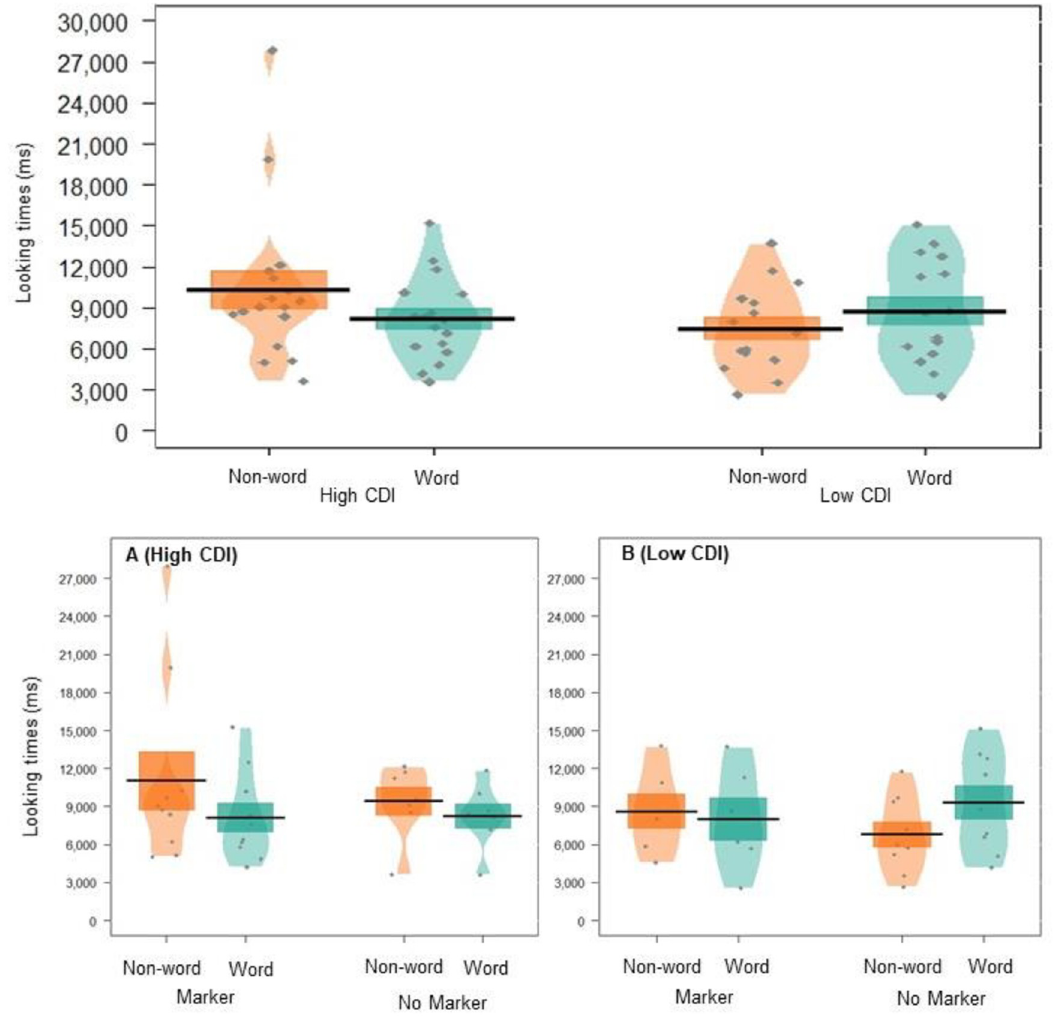
Fig 5. Pirate plot depicting the (raw) mean looking times to words and non-words for the participants in experiment 2. The top panel displays this data for High and Low CDI groups. The bottom panel breaks this down into each markers condition, with the High CDI group in panel A, and the Low CDI group in panel B. Black lines indicate the mean, and the coloured blocks indicate SE . Coloured shapes show the distribution of looking times for each group, with individual data points in grey.